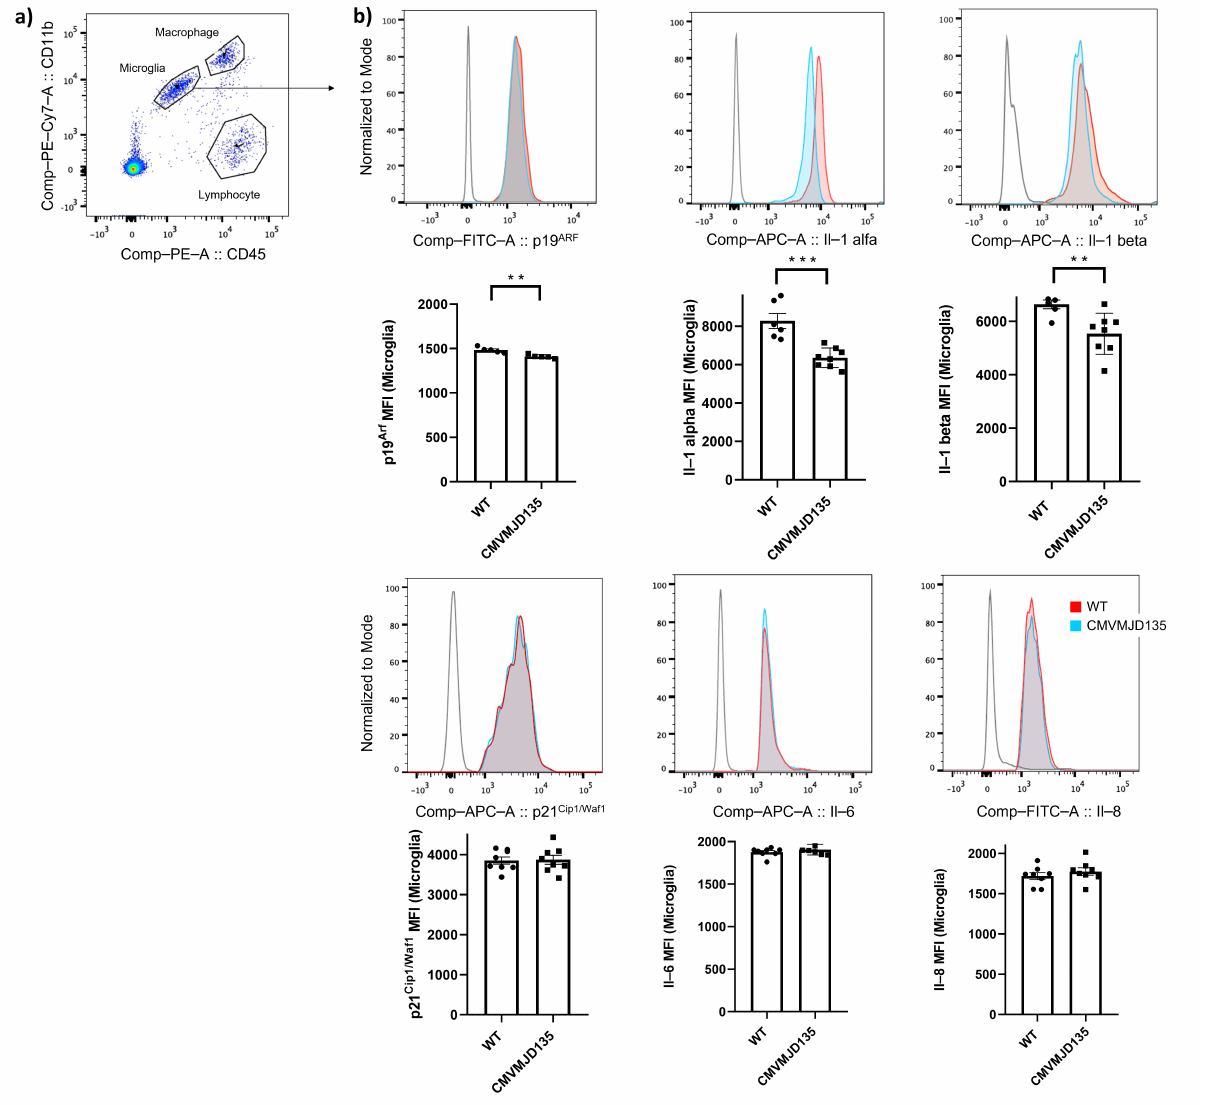
Figure 1. Expression of senescence markers is decreased in microglia of affected central nervous system (CNS) regions of CMVMJD135 mice. ( a ) Gating strategy used to analyze the flow cytometry data. Microglia, macrophage, and lymphocyte populations were gated using CD11b + CD45 mid , CD11b + CD45 high , and CD11b low CD45 low , respectively; ( b ) Flow cytometry showing expression of P19 Arf , Il-1 alpha, Il-1 beta, P21 Cip1/Waf1 , Il-6, and Il-8 in microglia (gated using CD11b + CD45 mid ) from wild-type (WT) and CMVMJD135 mice ( n = 5–8 per group). MFI = mean fluorescent intensity. Data are presented as mean + SEM (Student’s t -test). **, ***, represent p < 0.01 and p < 0.001,